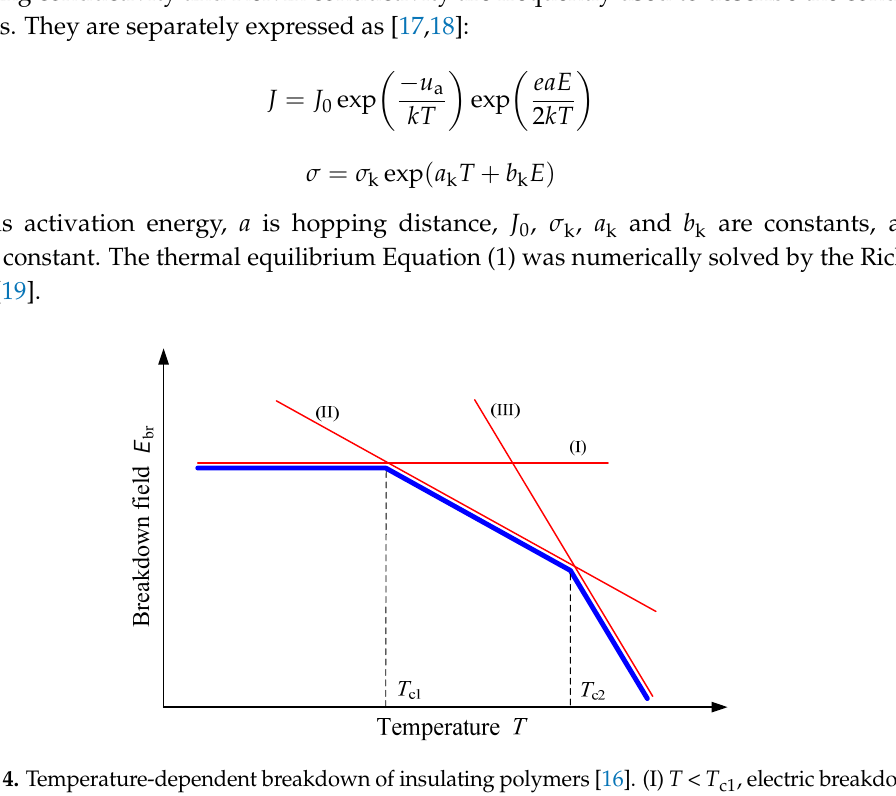
Figure 4. Temperature-dependent breakdown of insulating polymers [16]. (I) T < T c1 , electric breakdown; (II) T c1 < T < T c2 , thermal or electro-thermal breakdown; (III) T > T c2 , electro-mechanical breakdown.